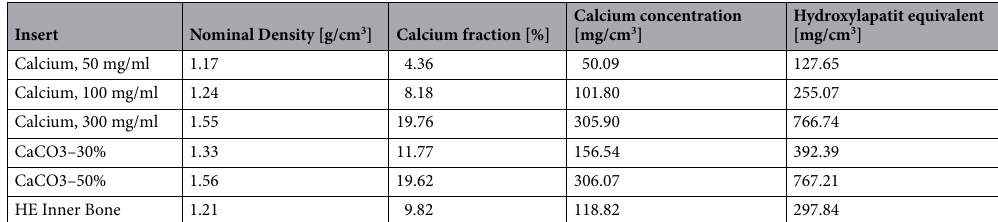
Table 1. Specifications of the phantom inserts. Calcium concentrations were calculated from given density and calcium fraction. Equivalent concentrations of Hydroxylapatite were calculated based on the calcium